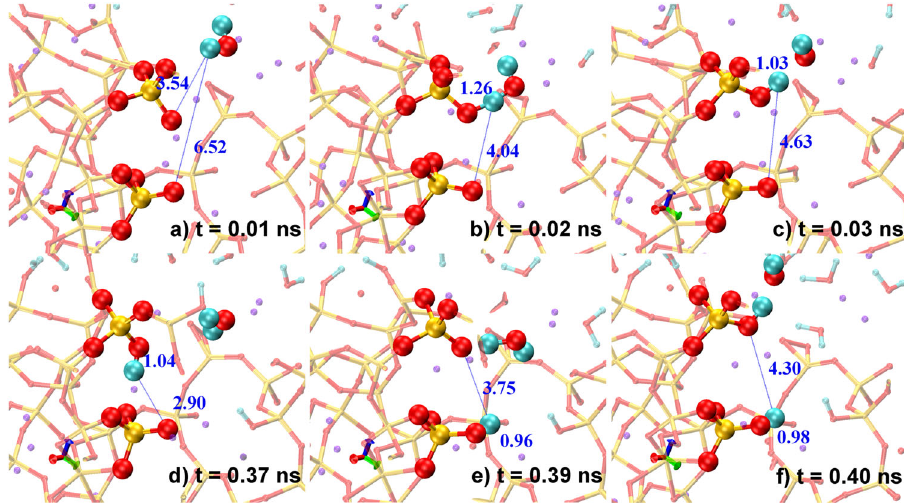
Fig. 9 Continuous reactions that led to the formation of two silanol groups in adjacent tetrahedra involving proton transfer. Con fi gurations a – f are the snapshots at different reaction stages (with the time labeled). The top side of each con fi guration is closer to the glass – water interfacial